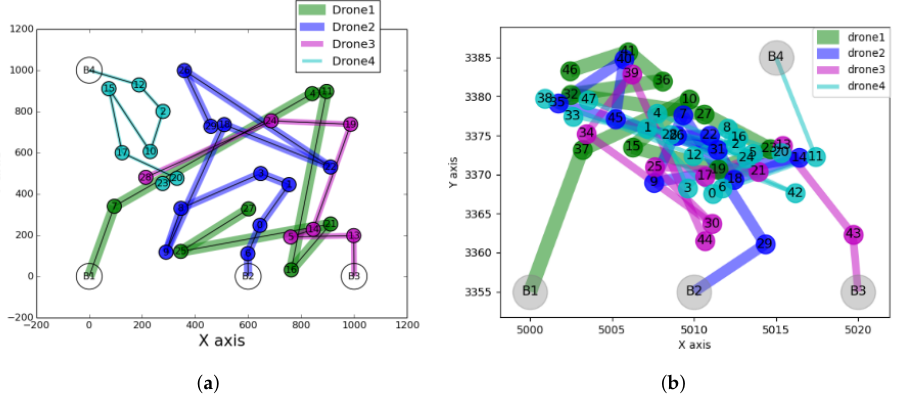
Figure 4. Path generation when the UAVs have the same speed. ( a ) Path generation on a random network; ( b ) Path generation on a real network. Table 2. Delivery when all speeds are the same.